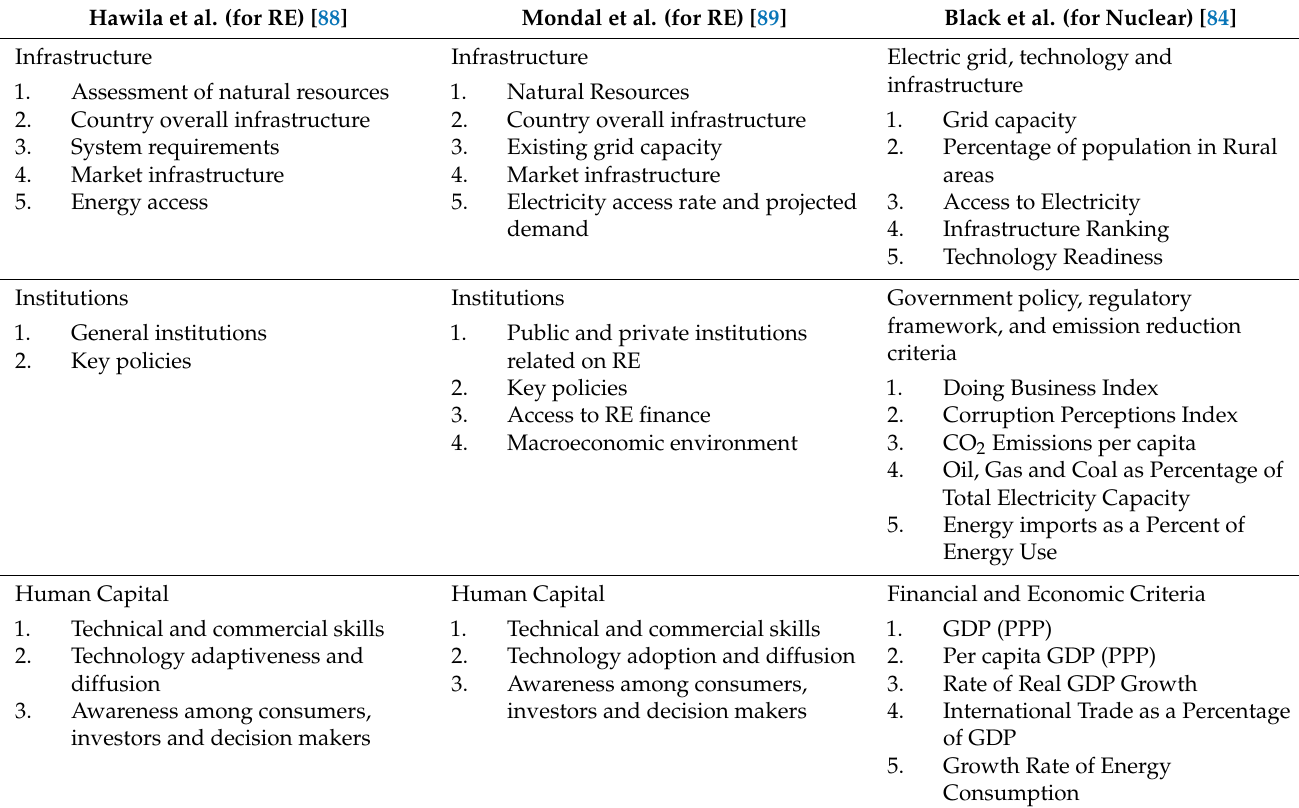
Table 8. Criteria for readiness indices for RE/nuclear